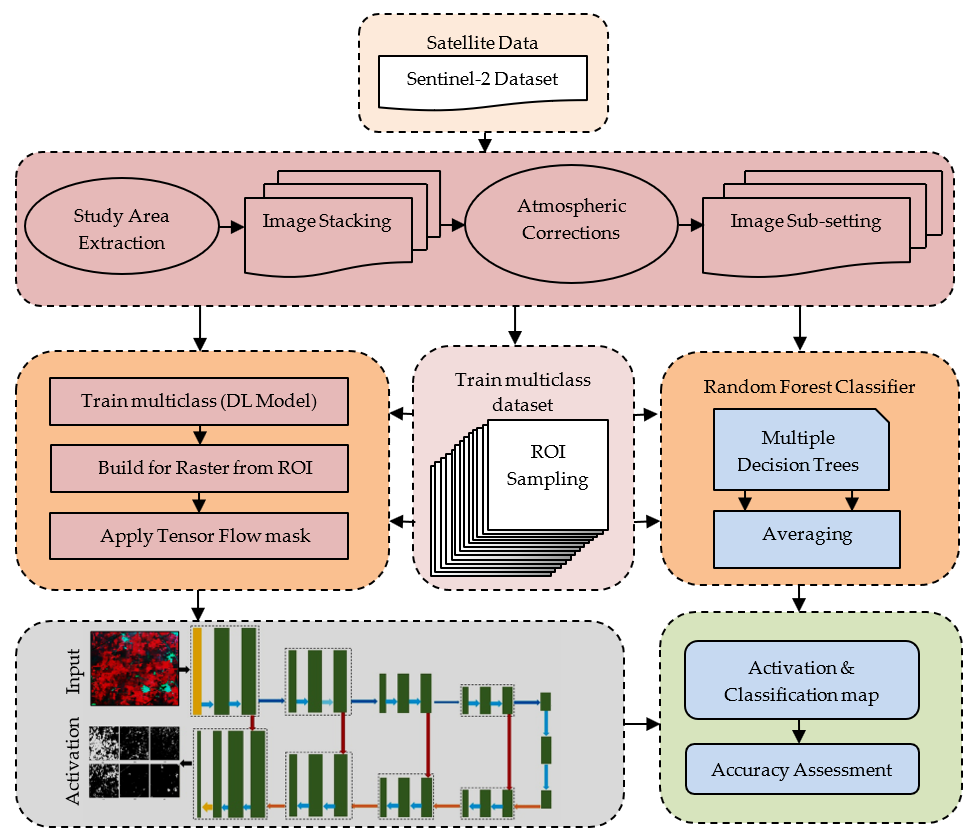
Figure 2. An operational model for the mapping of agricultural land using ENVINet5-based deep learning.